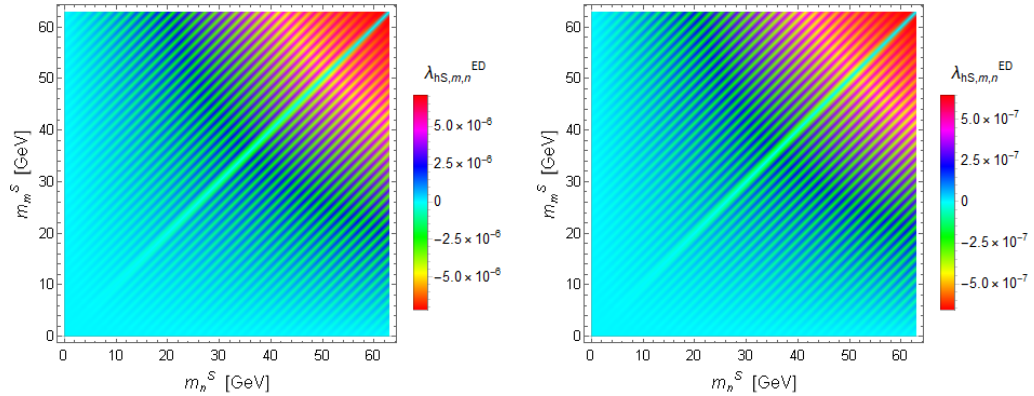
Figure 10 . Couplings (cid:21) ED up to m S = 62 GeV for BM II, with (cid:14) T (cid:11) = 1 GeV (left) and hS;m;n m ( n ) (cid:14) T (cid:11) = 10 GeV (right). The other parameters are the same as in (cid:12)gure